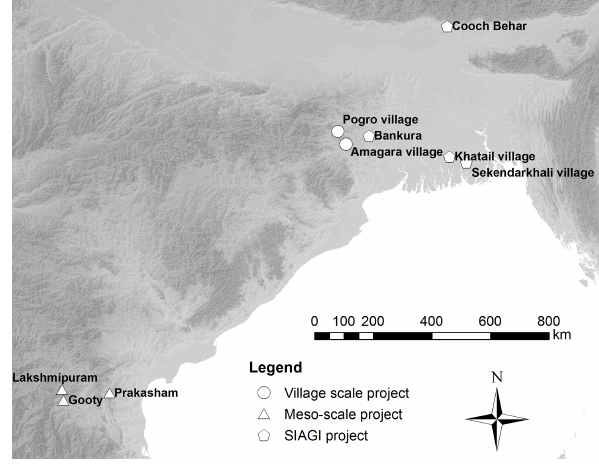
Figure 1. Map showing locations of the study sites for the three